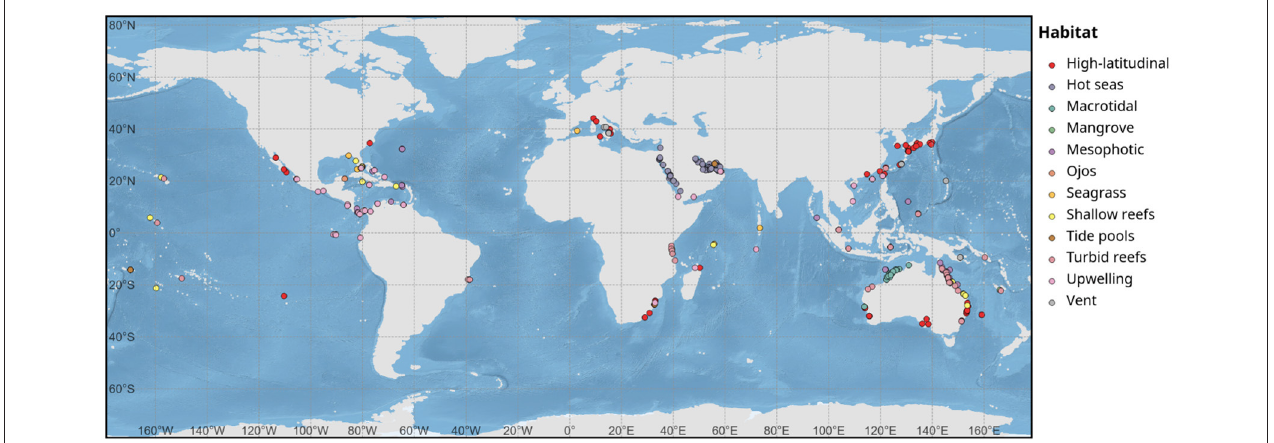
FIGURE 3 | A global map showing the study locations of the extreme and marginal coral